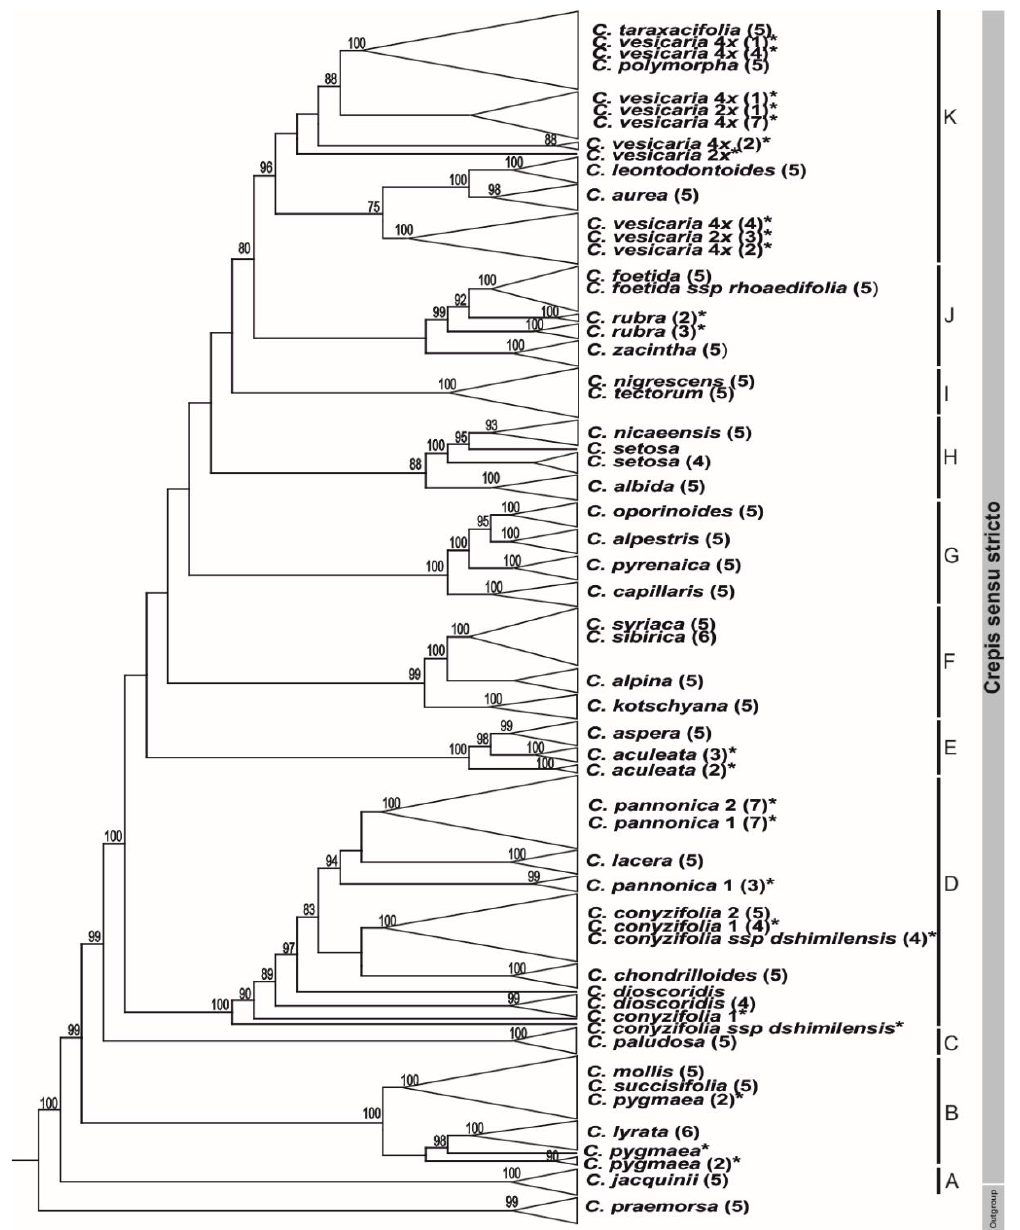
Figure 2. Phylogenetic analysis of the cloned sequences of 5S rDNA non-transcribed spacer repre- senting species of Crepis s.s. lineage. Numbers in parentheses indicate the number of clones analysed. The tree was rooted with C. praemorsa . Bootstrap scores are shown above branches. Stars indicate species with two variants of 5S rDNA NTS. A – K letters indicates clades. In the ML analysis of the nrITS region, two main well-supported evolutionary lineages were recovered: Lagoseris (BS94) and Crepis s.s. (BS85; Figure 3). In Crepis s.s . , four main clades (1 – 4) that had high bootstrap support (BS72-BS100) were found. The newly sequenced C. chondrilloides was recovered in clade 3 (Figure S3).